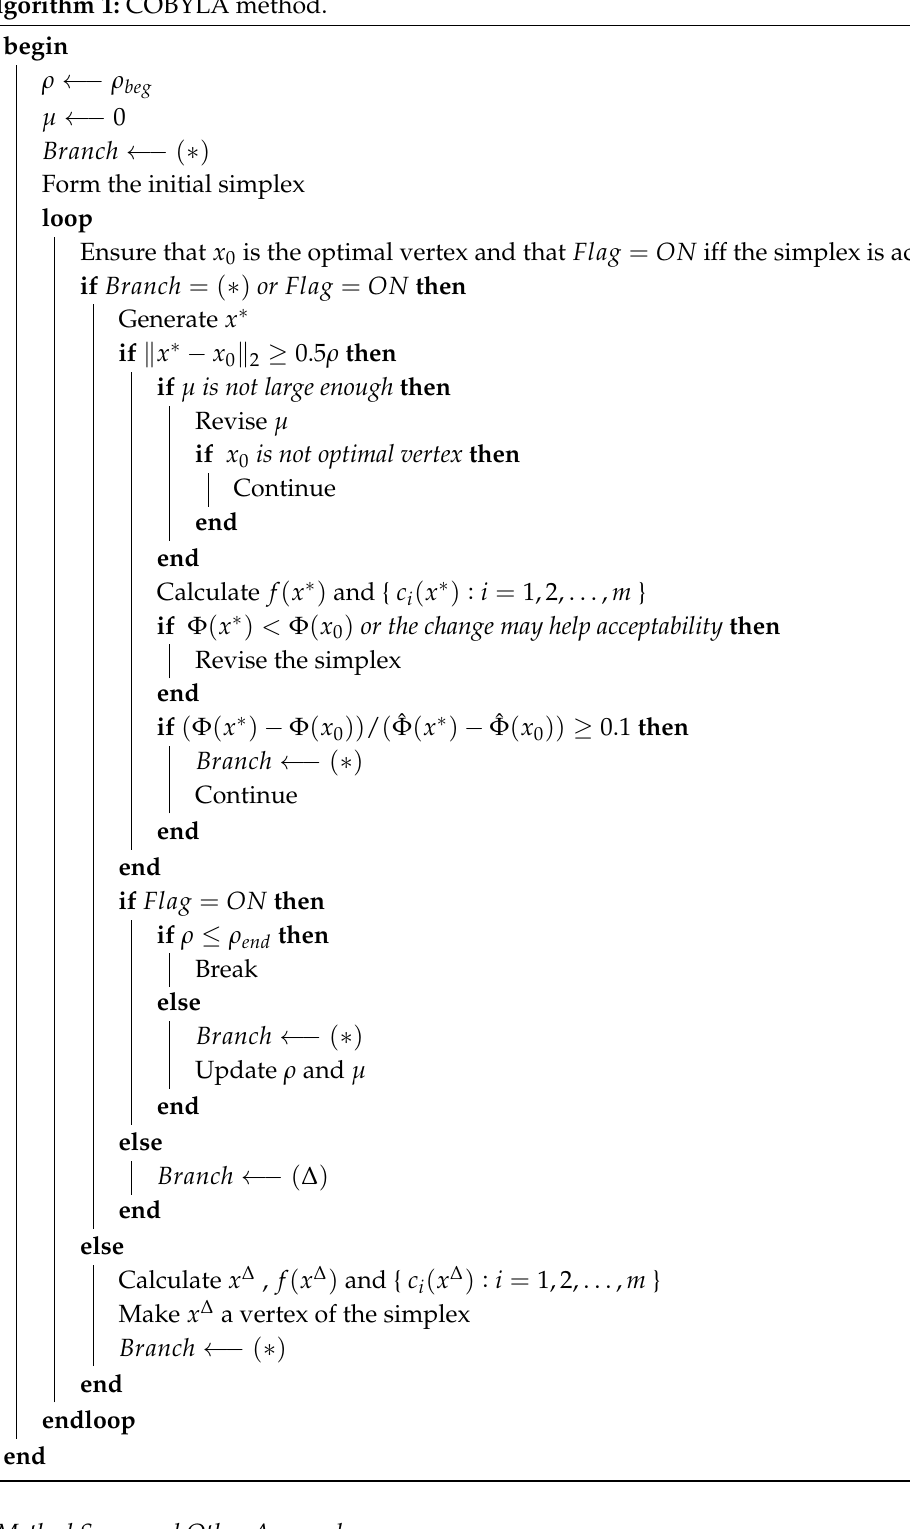
Algorithm 1: COBYLA